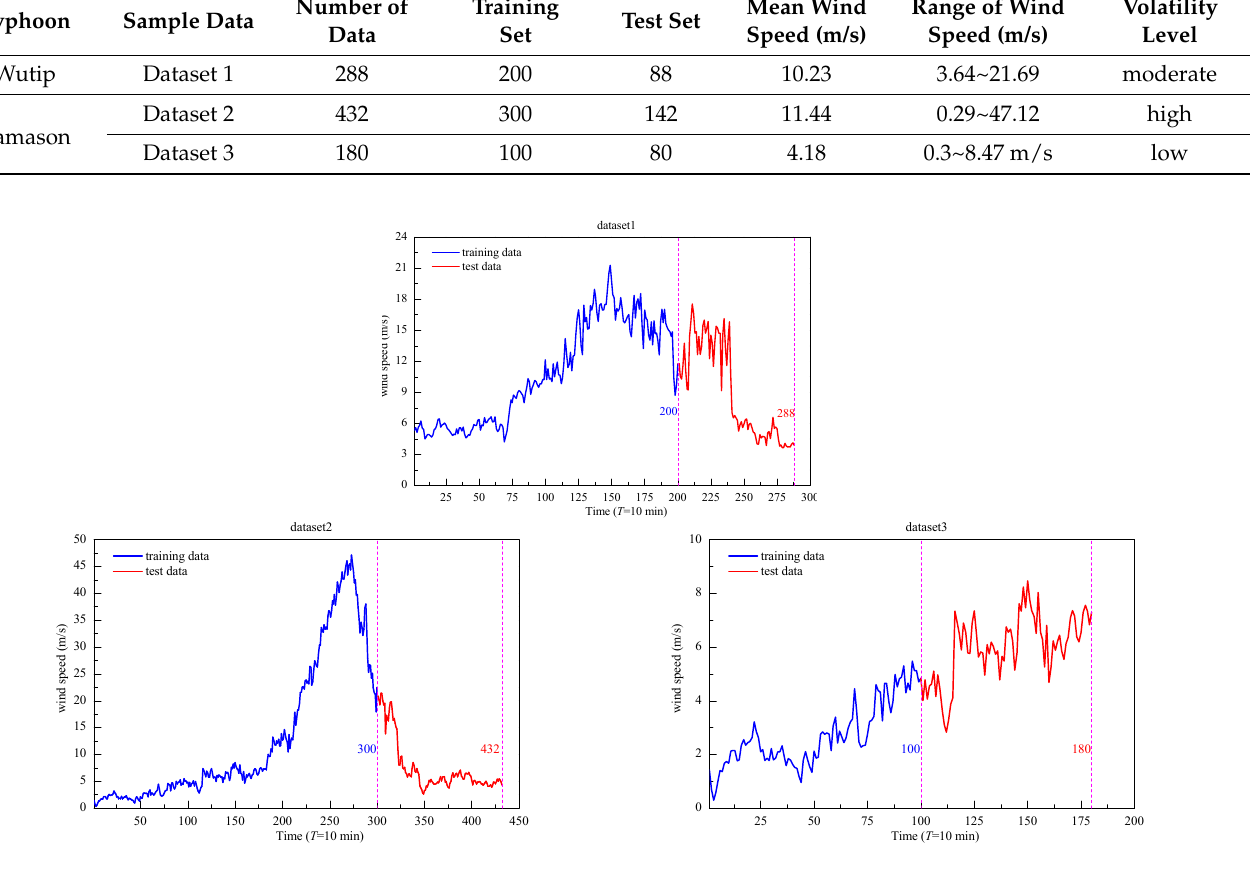
Figure 2. Three wind speed datasets.